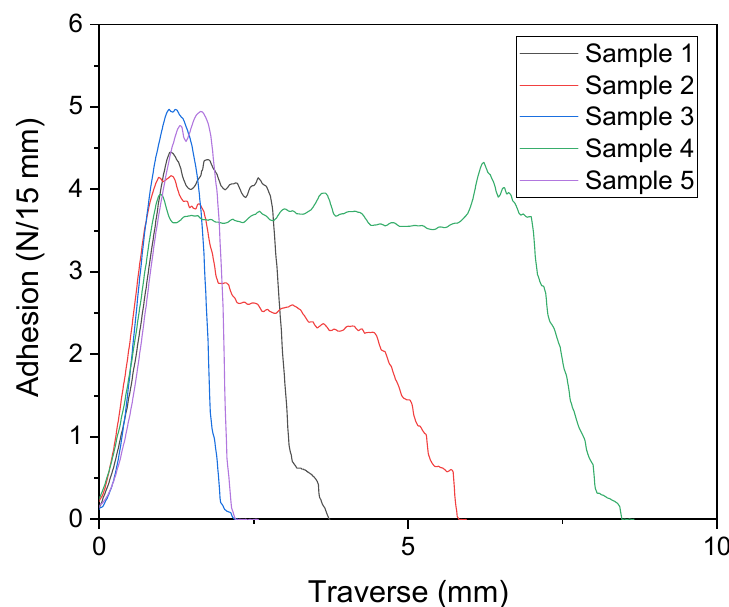
Figure 9. T-peel test results of the cured PET//LDPE laminate.